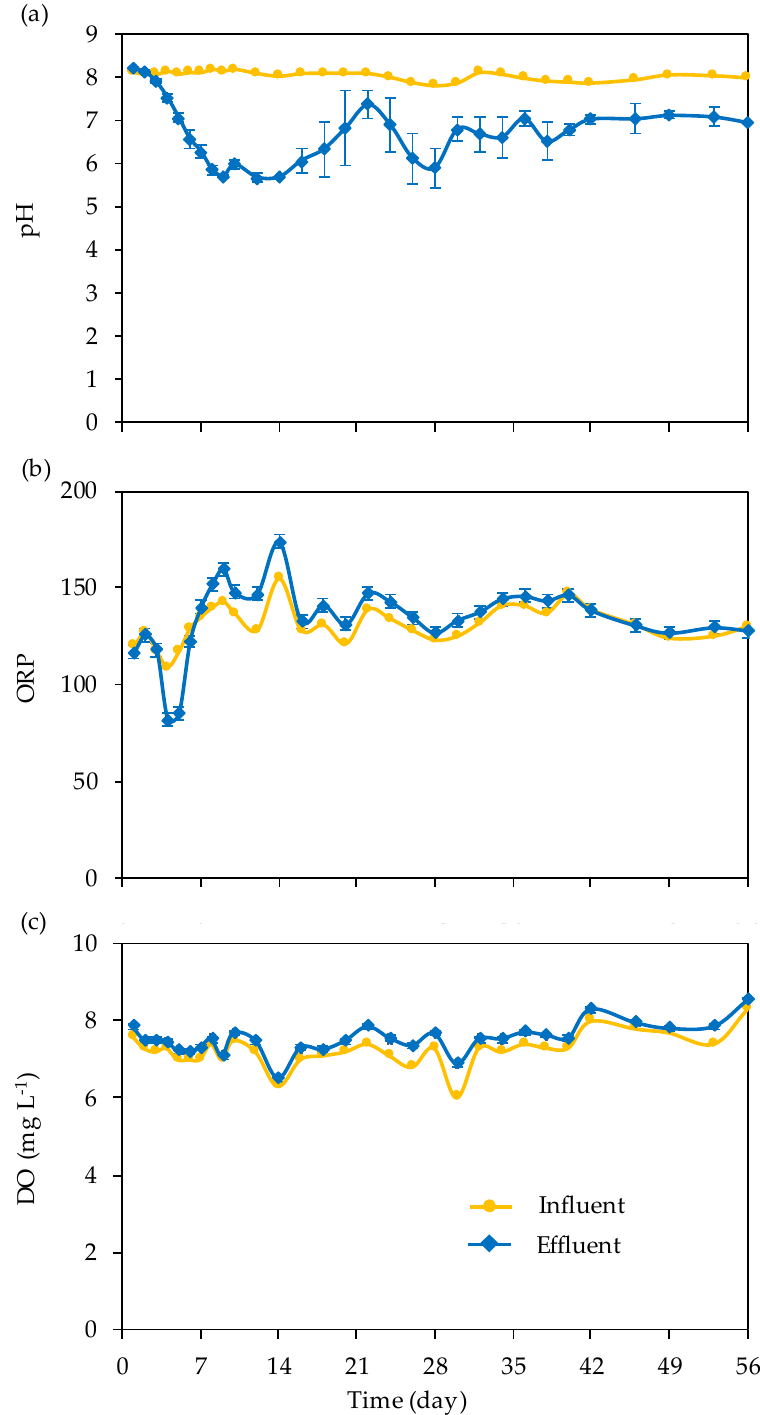
Figure 1. Changes in pH ( a ), redox potential (ORP) ( b ), and dissolved oxygen (DO) ( c ) in the influent and effluent samples over 56 days of operation. Effluent values are means ± SD ( n = 4).